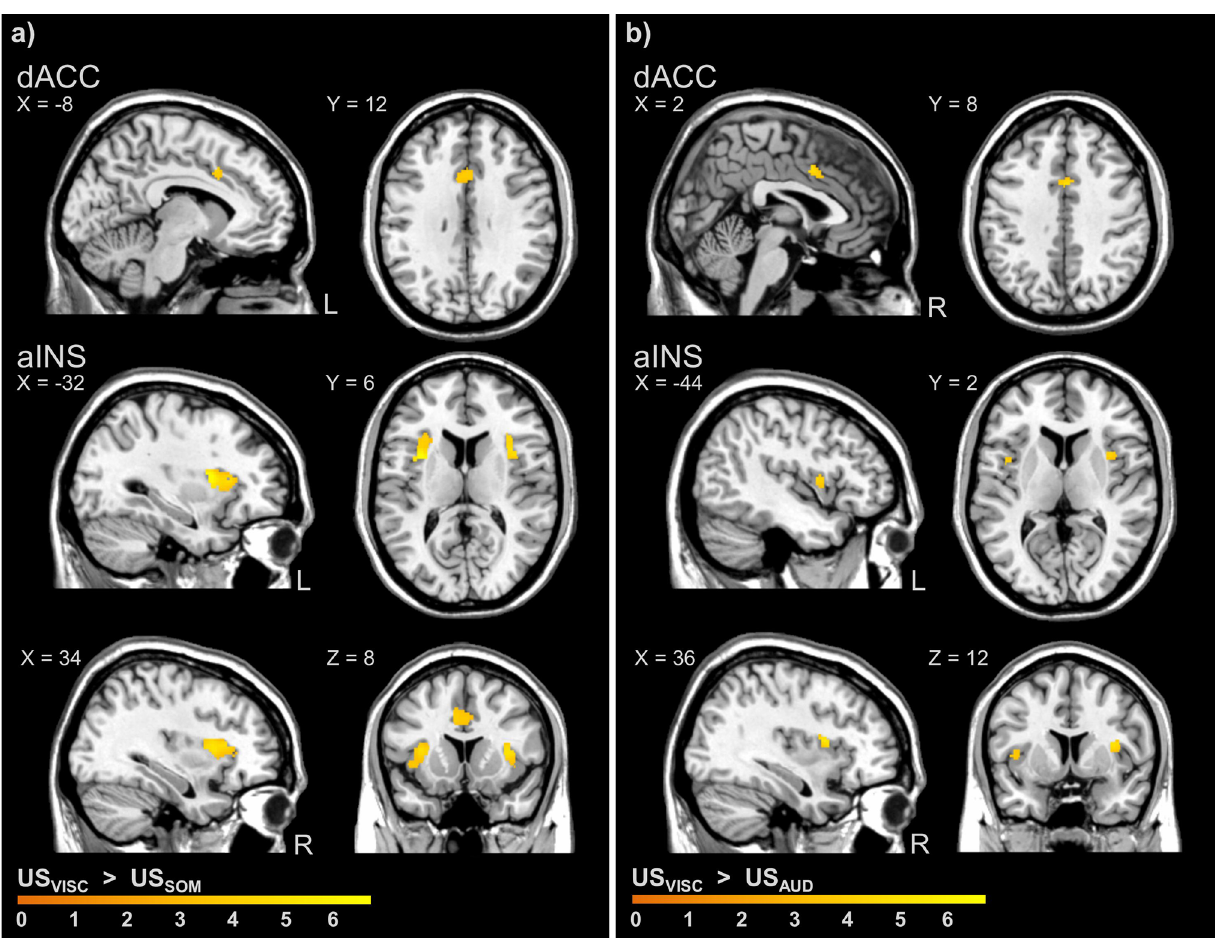
Fig. 1 Differences in neural activation induced by interoceptive versus exteroceptive threats implemented as unconditioned stimuli (US) during acquisition in studies 1 and 2. Interoceptive threat (US VISC ) induced signi fi cantly greater neural activation in dACC and aINS compared to both exteroceptive threats ( a study 1, compared to US SOM ; b study 2, compared to US AUD ; all P FWE < 0.05). Moreover, interoceptive and exteroceptive threats induced shared neural activation in different brain regions across studies (full results in Supplementary Table S3). Neural activations in regions of interest were superimposed on a structural T1-image and thresholded at P < 0.001 uncorrected for visualisation purposes; colour bars indicate t -scores. For details, see Table 1. For whole-brain results on differential activation, see Supplementary Fig. S4. aINS anterior insula, AUD auditory, dACC dorsal anterior cingulate cortex, FWE family-wise error, SOM somatic, US unconditioned stimuli, VISC